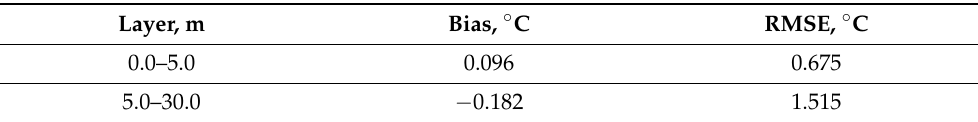
Table 6. Accuracy estimates (mean and standard deviations) of MHI reanalysis model in the Black Sea from report